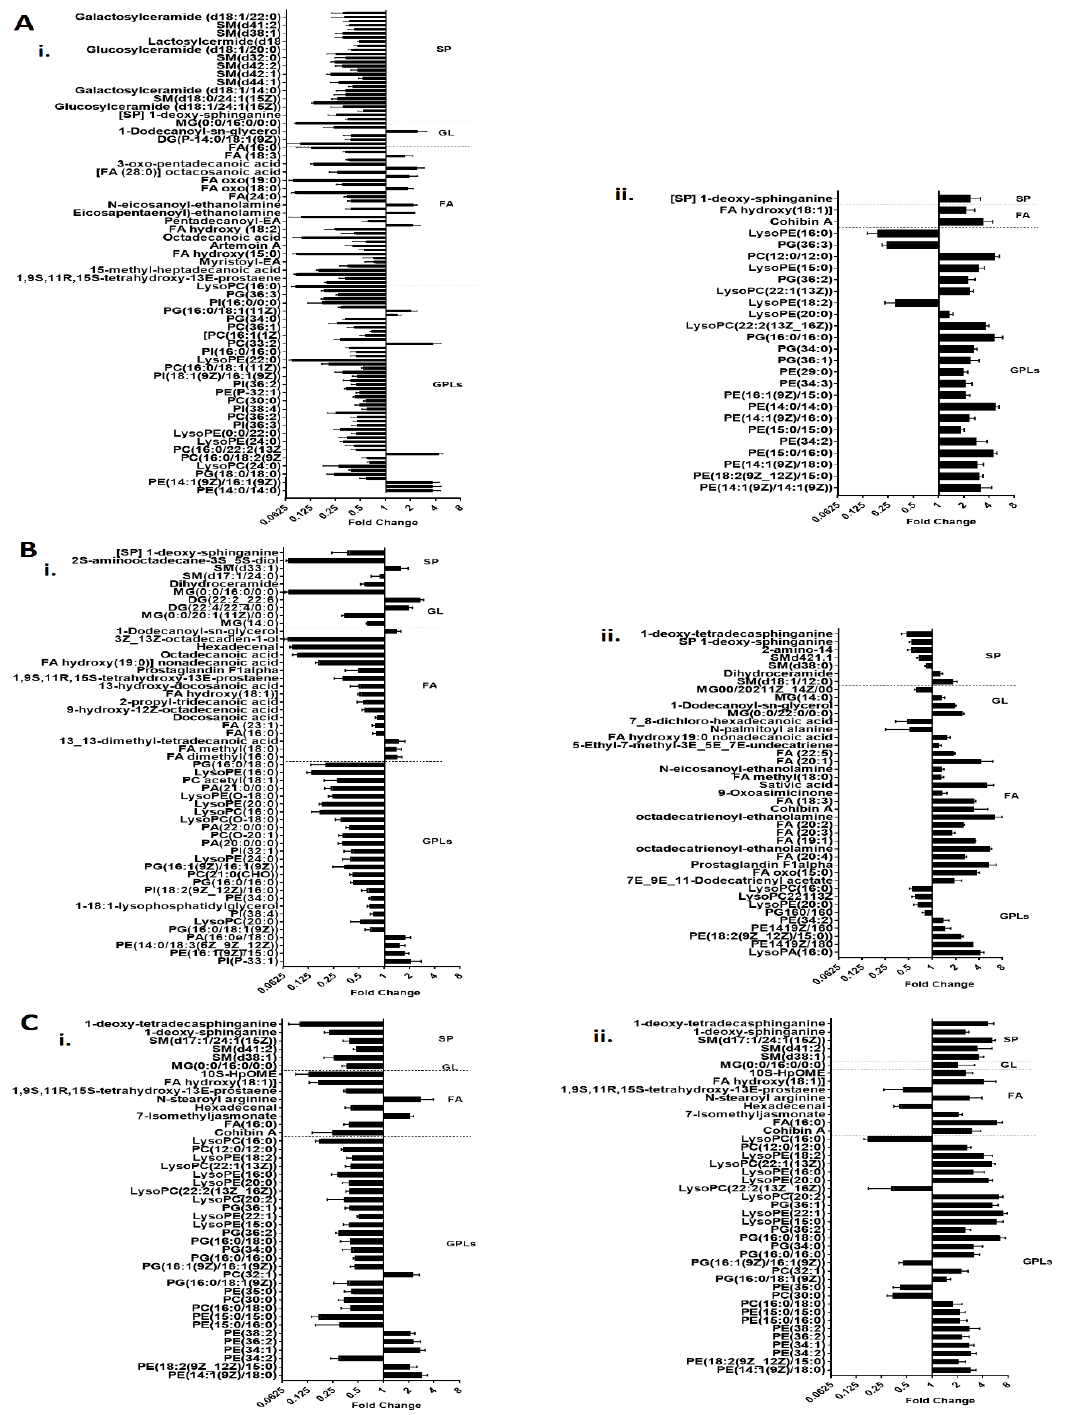
Figure 3. Lipidomic perturbations of OMVs isolated from polymyxin-susceptible and -resistant K. pneumoniae isolates. Fold-change of lipids relative to the untreated control cells, in OMVs of the polymyxin-susceptible ( i ) and -resistant ( ii ) strains of paired K. pneumoniae isolates in response to polymyxin B treatment (2 mg/L). ( A ) K. pneumoniae ATCC 700721. ( B ) K. pneumoniae BM3 and ( C ) K. pneumoniae FADDI-KP069. GPLs = glycerophospholipids; FA = fatty acids; GL = glycerolipids; SP = sphingolipids.